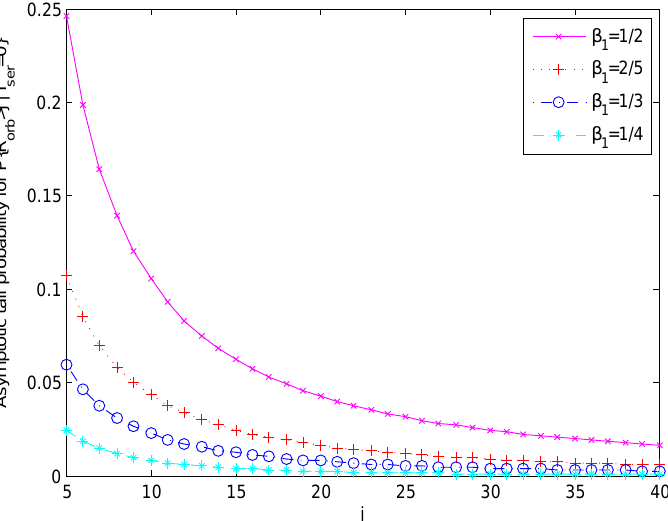
Figure 2. Impact of the expected service time β 1 on the asymptotic tail P { R orb > j | I ser = 0 } .